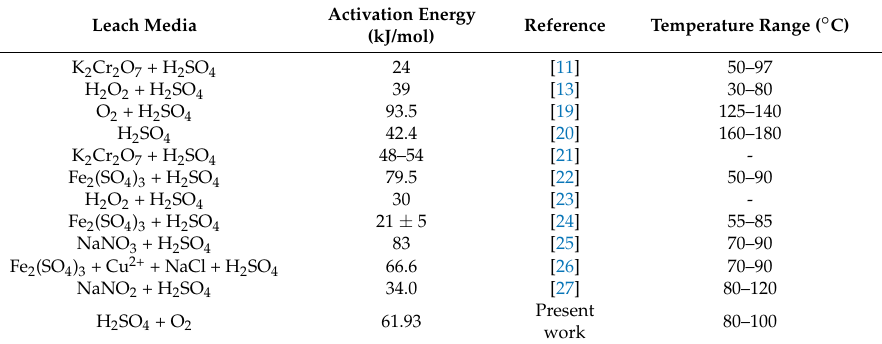
Table 11. Results reported in literature of activation energy for chalcopyrite Figure 14. Logarithm of the apparent velocity constant versus the inverse of temperature.